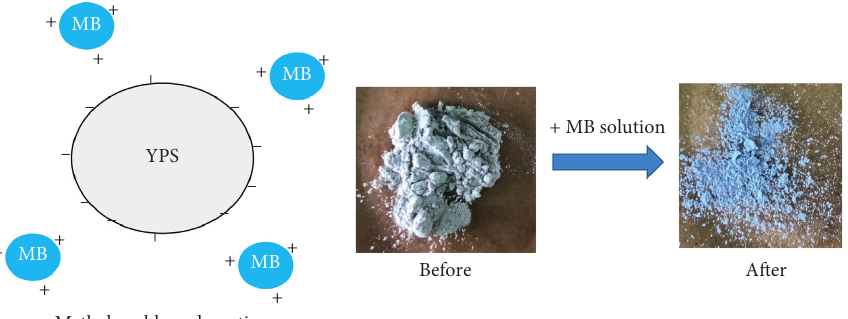
Figure 9: A hypothesis model for the adsorption of MB ions by YPS2 particles.